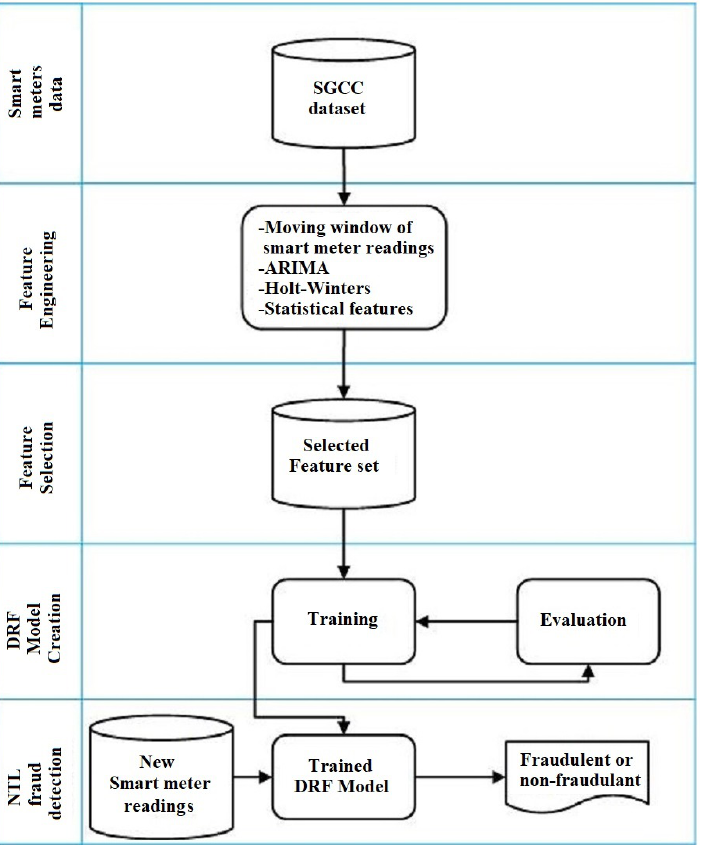
Figure 1. The proposed NTL fraud detection